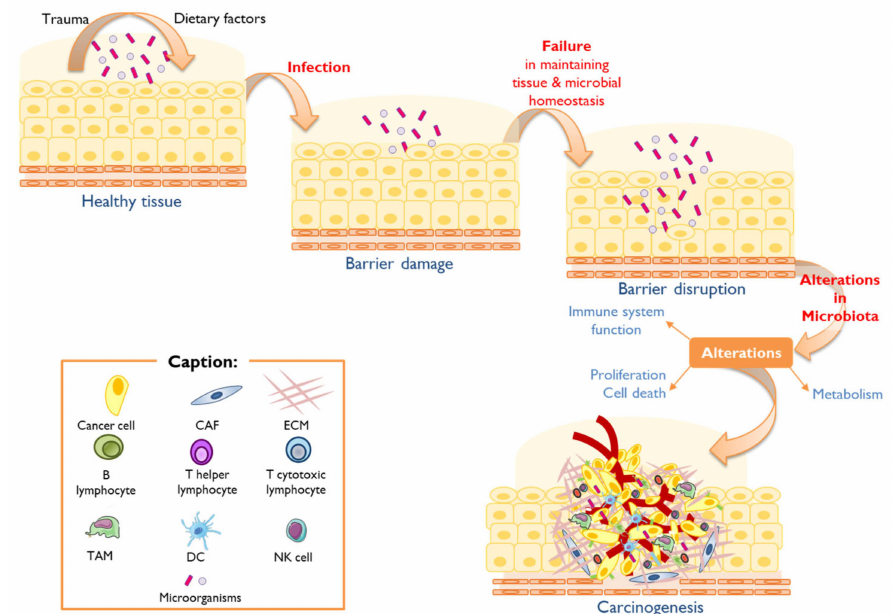
Figure 2. The contribution of microbiota on the solid tumor carcinogenesis process. Human body barriers are subject to constant environmental insult and injury. Trauma and dietary factors can contribute to the breach of the mucosal barriers, leading to infection. Generally, mucosal barrier damage is rapidly repaired, and tissue homeostasis is restored. However, decreased host resiliency contributes to persistent barrier damage, leading to its disruption and failure in homeostatic repair. In these settings, the microbiota may influence carcinogenesis by (i) altering host cell proliferation and death, (ii) perturbing immune system function, and (iii) influencing metabolism